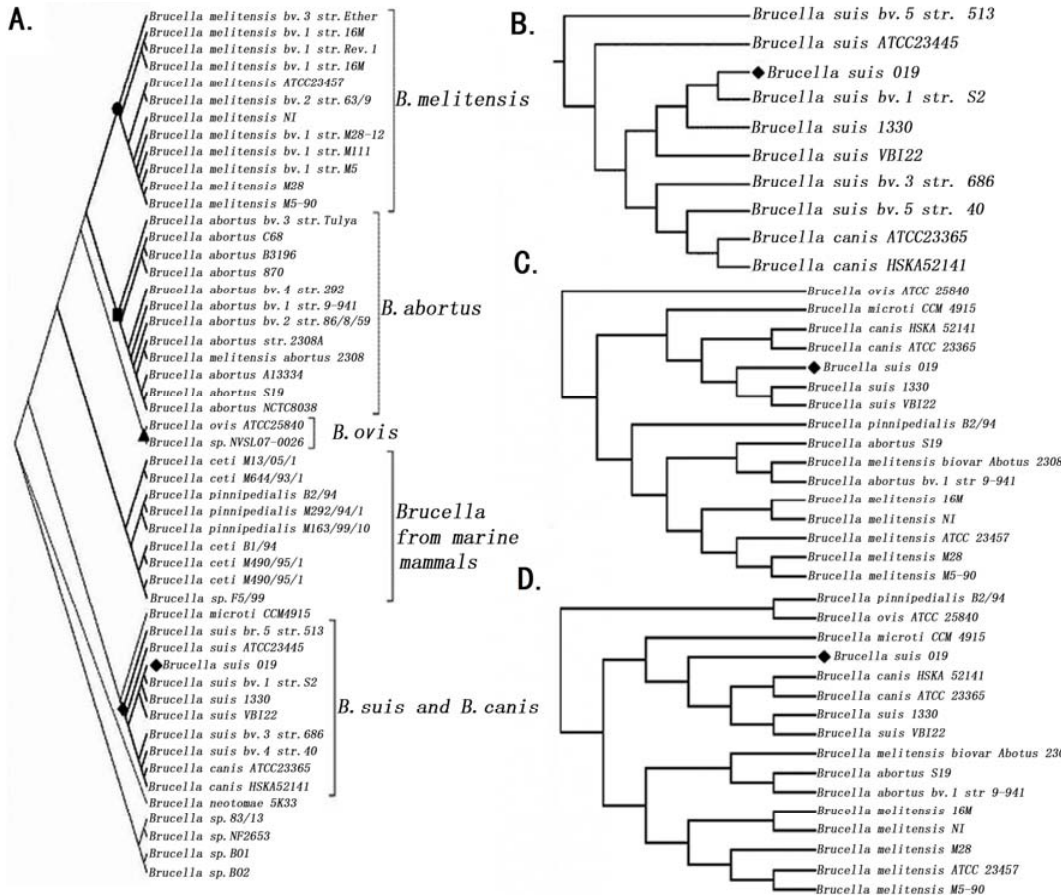
Figure 1. The phylogenetic trees. A. Phylogenetic Tree 1 was built using homologous genes from 51 Brucella genomes (including 019 draft genome). B. A magnified view of Brucella suis and canis clades was from Phylogenetic Tree 1. C. Phylogenetic Tree 2 was built using chromosome 1 sequences from 15 Brucella complete genomes (including 019 complete genome). D. Phylogenetic Tree 3 was built using chromosome 2 sequences from 15 Brucella complete genomes (including 019 complete genome).